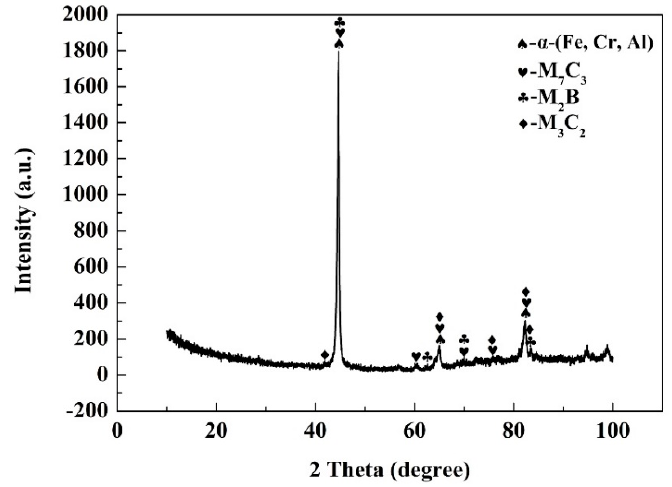
Figure 4. The X-ray pattern of high aluminum and chromium Fe-B-C coating. Table 2. Chemical compositions of the phases with di ff erent morphologies in high aluminum and chromium Fe-B-C coating